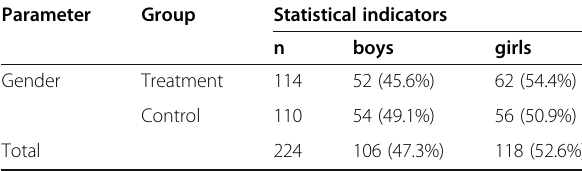
Table 2 Allocation of patients according to sex